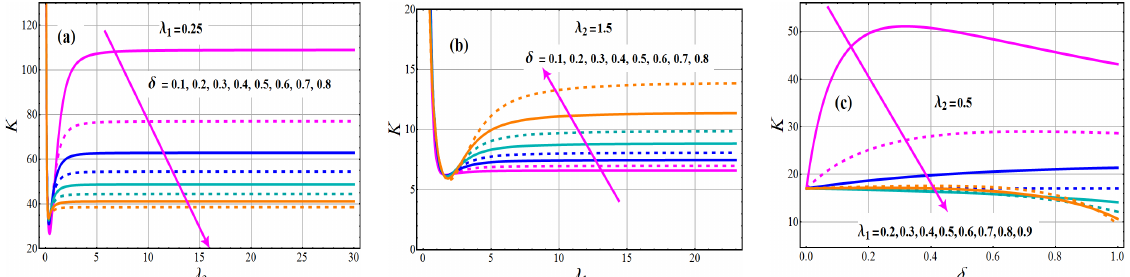
Fig. 6. Variations of Coe¢ cient of Skewness SK , of TC-MAM ( $ ) .